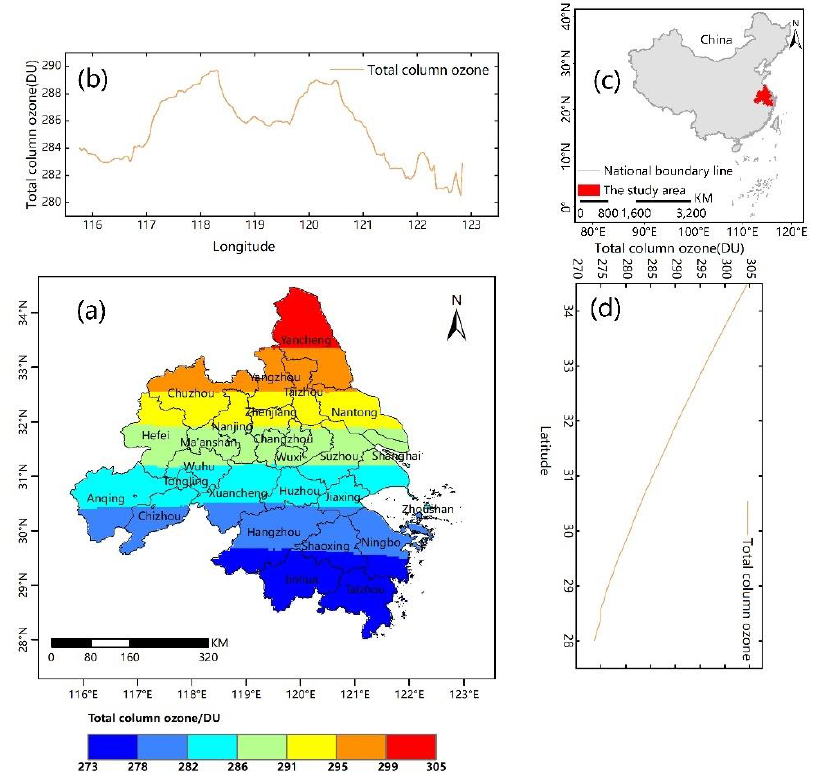
Figure 1. ( a ) Spatial distribution of the 20-year average TCO over the Yangtze River Delta Urban Agglomerations during 2000 – 2019. This result was calculated by averaging all annual TCO over the study area. ( b ) Longitudinal TCO variation in the study area. ( c ) Location of the study area. ( d ) Latitudinal TCO variation in the study area.